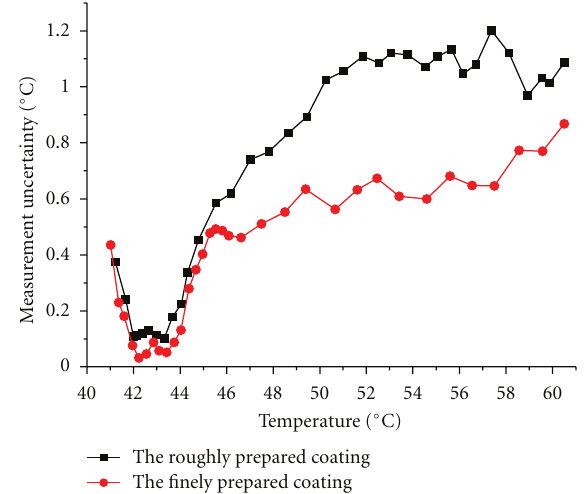
Figure 9: The measurement uncertainty for the rough and fine TLC